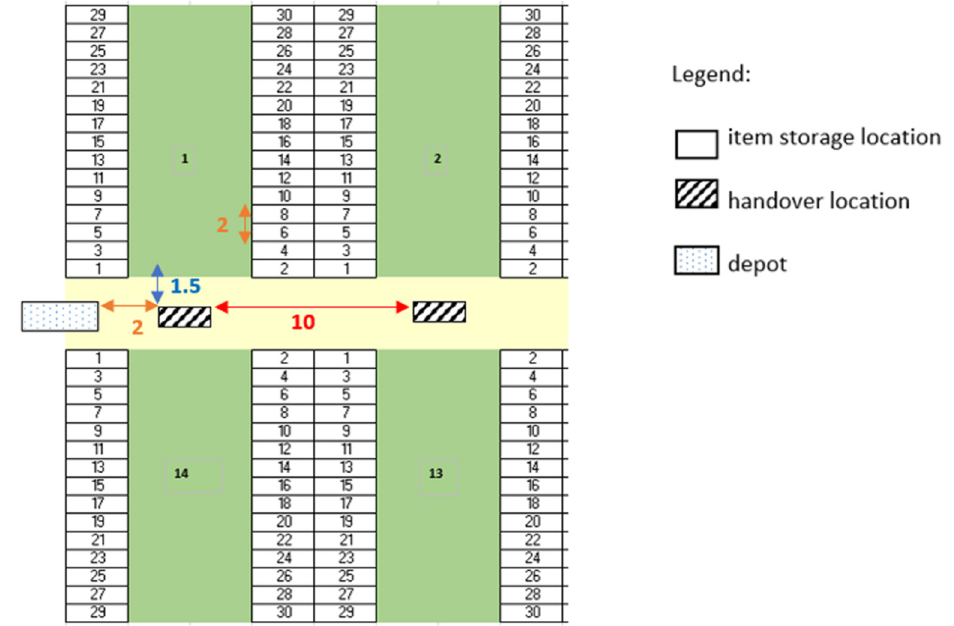
Figure 5. Distances in the two-blocks layout with shared handover locations (meters).